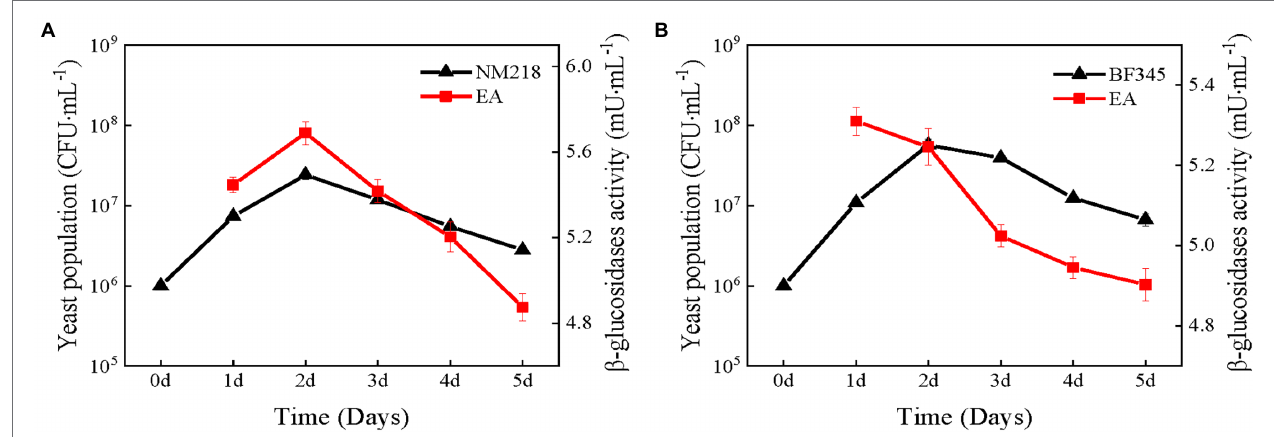
FIGURE 1 | Yeast population dynamics and β -glucosidase activity during synthetic must fermentation. (A) pure fermentation of M. guilliermondii NM218. (B) pure fermentation of H. uvarum BF345. The black line in the graph indicates the NS yeasts population and the red line indicates the β -glucosidase activity (EA).